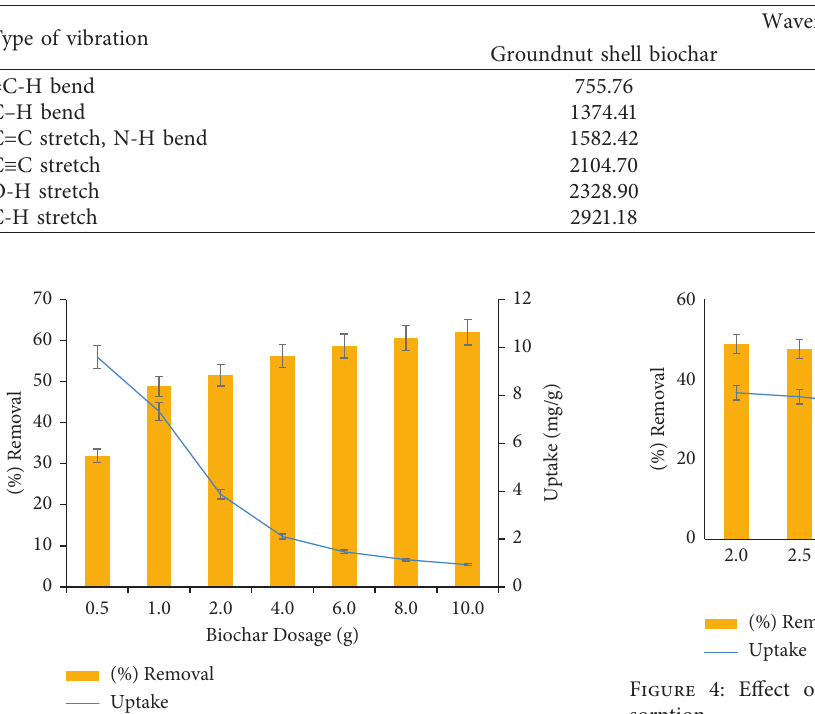
Figure 3: Effect of biochar dosage on RY145 removal and sorption.